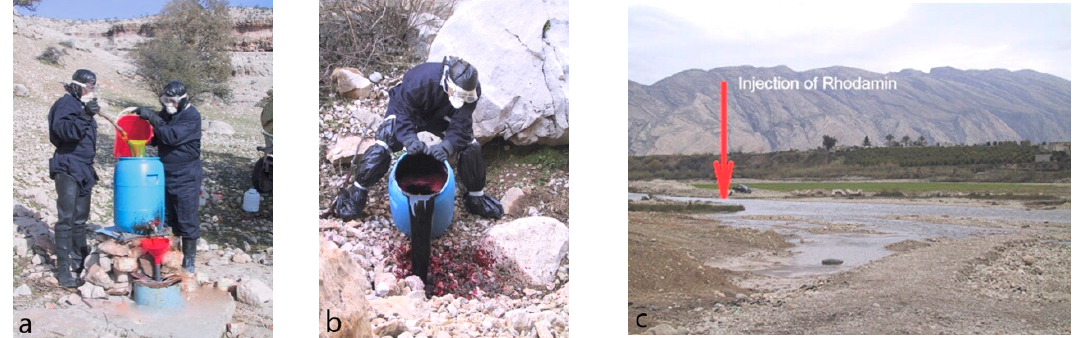
Figure 4. Tracer test: ( a ) injection of uranine in the Tel Milek borehole, ( b ) injection of eosine located 3.25 km N-NE of Sasan spring, ( c ) injection of rhodamine in Shapour River, upstream of Sasan spring.